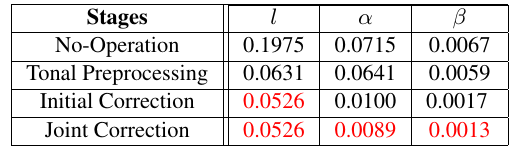
Figure 7. The experimental results on the synthetic image data: (a) the original image with red border lines of clipped images with a 20% overlap between two adjacent ones; (b) the manually adjusted images individually via Photoshop displayed as a single simply mosaicked image; (c) the tone-preprocessed result, in which all clipped images present at a similar luminance but the color deviations between adjacent images do not disappear; (d) the finally corrected result, which presents a consistent tone on the whole with the reference subset { 11,12,13,16,18,19,21,23,24,25 } ; (e)-(f) two enlarged representative regions shown with the manually adjusted results, the tone-preprocessed ones, and the finally corrected ones from left to right.